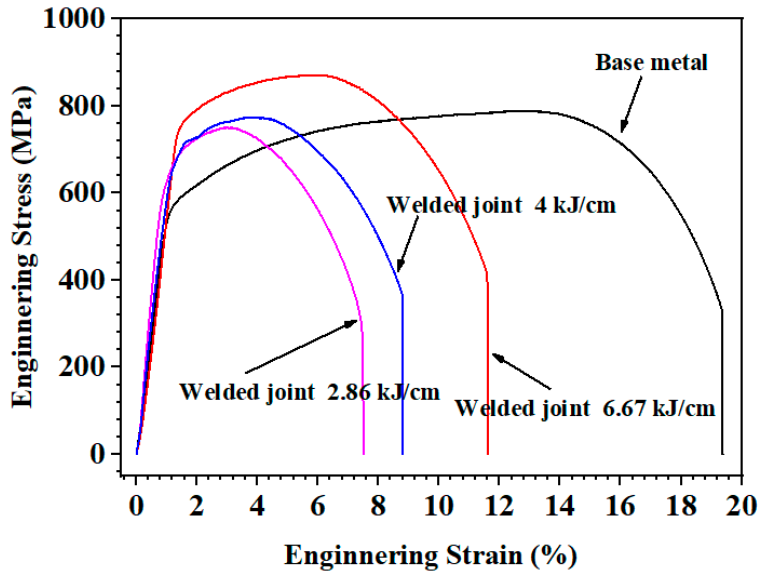
Figure 8. Nominal stress–strain curves of the X80 pipeline steel and its welded joint. Table 2. Tensile test results of welded joints.